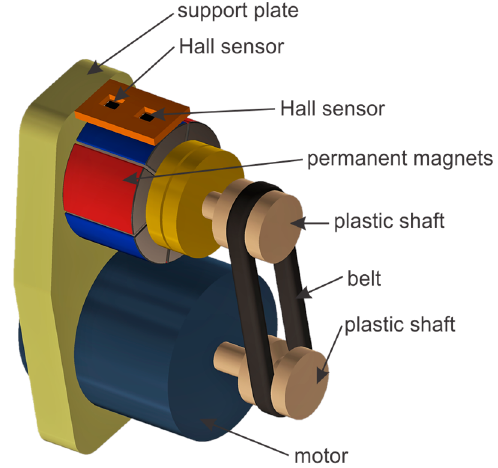
Figure 1. Simplified view of the eddy current transducer.